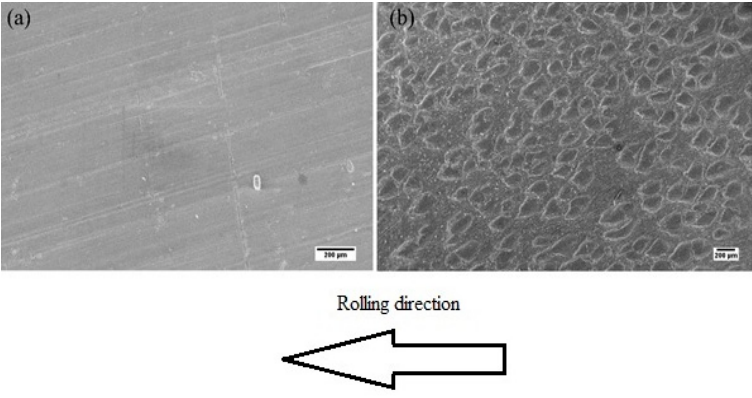
Figure 1. The surface of aluminum strips ( a ) before wire brushing and ( b ) after wire brushing.